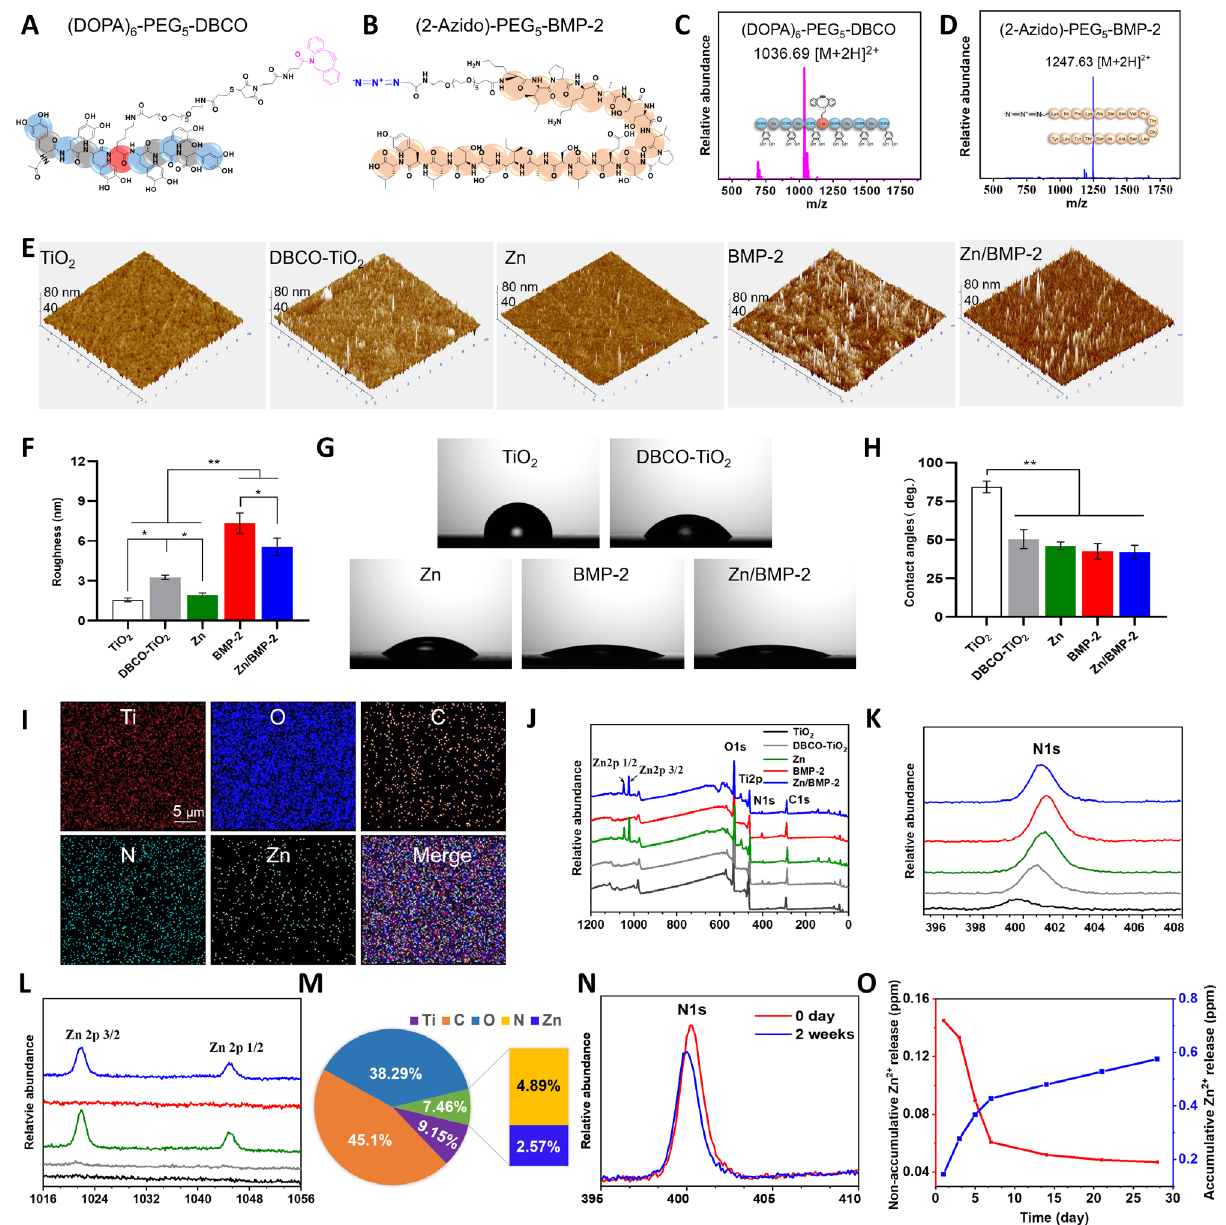
Fig. 2 Characterizations of clickable peptide and Zn 2 + and BMP-2 peptide co-modi fi ed surface. A , B The molecular structures of (DOPA) 6 -PEG 5 -DBCO and (2-Azido)-PEG 5 -BMP-2. C , D ESI-MS spectra of the two synthetic peptides. E AFM images of different surfaces and ( F ) quantitation of the suface roughess with the different modi fi ed surfaces ( n = 3 independent samples per group, by a one-way ANOVA with a Tukey ’ s post hoc test for multiple comparisons). Data are reported as mean ± SD, * p < 0.05, ** p < 0.01). G The water contact angles of different surfaces and ( H ) the quantitative results ( n = 3 independent samples per group, by a one-way ANOVA with a Tukey ’ s post hoc test for multiple comparisons. Data are reported as mean ± SD, ** p < 0.01). I SEM-EDS elemental mapping for the Zn 2 + and BMP-2 peptide co-modi fi ed surface (Zn/BMP-2) (scar bar = 5 μ m, three independent experiments). J – L XPS analysis of the bare and modi fi ed TiO 2 surface (DBCO-TiO 2 , Zn, BMP-2 and Zn/BMP-2. M Quantitative elemental analysis according to XPS. N Changes of N 1 s signal in the XPS spectrum of the Zn/BMP-2 surface after incubated in DMEM for 2 weeks. O Zn 2 + release pro fi les of the Zn/BMP- 2 surface in PBS solution; red (left) and blue (right) represent the non-accumulative and accumulative Zn 2 + release, respectively. Exact P values were given in the Source Data fi